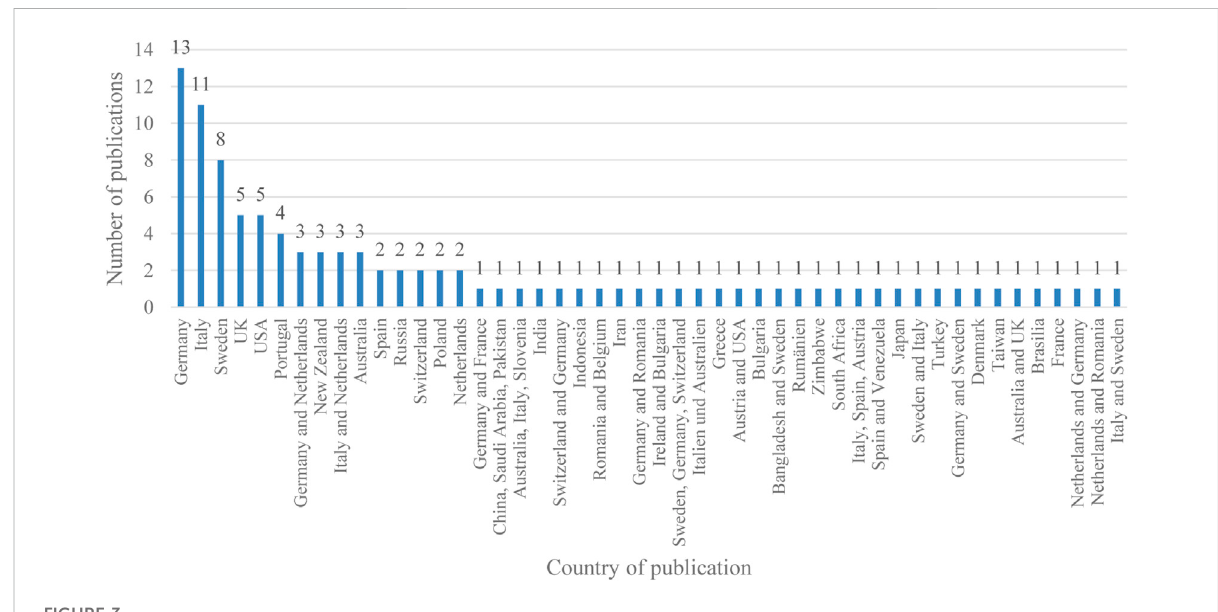
FIGURE 3 Countries of studied